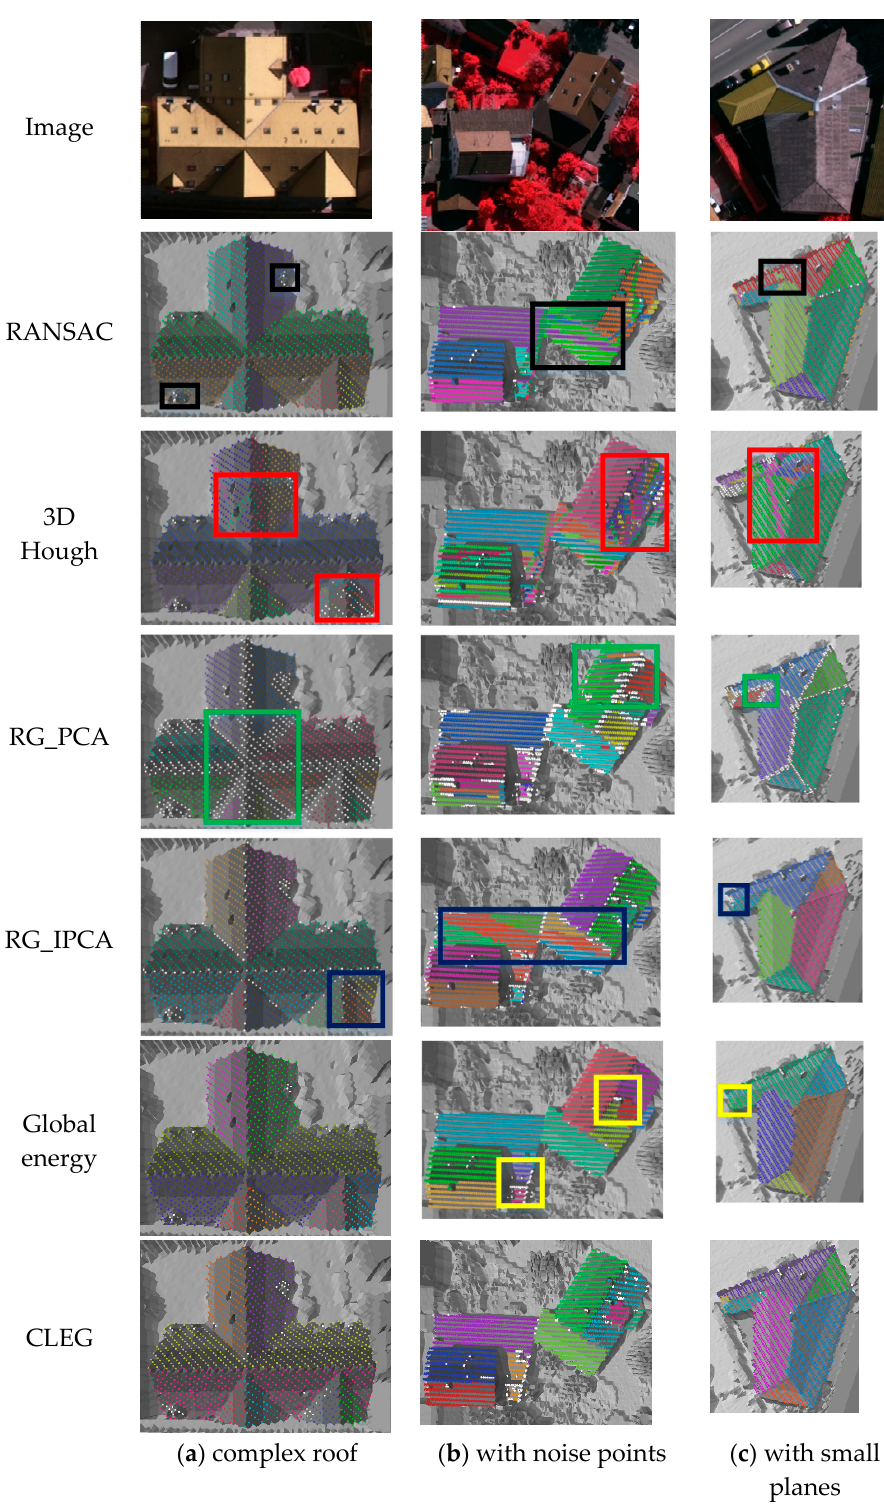
Figure 8. Segmentation of roof points in Vaihingen. ( a ) complex roof; ( b ) with noise points; ( c ) with small planes.